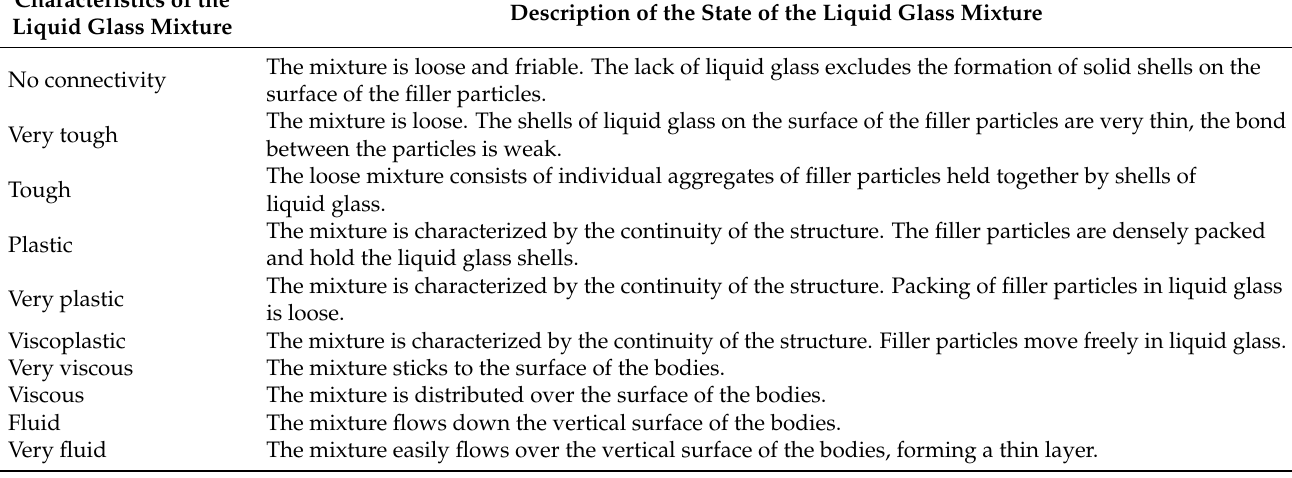
Table 3. Gradation of the state of liquid glass